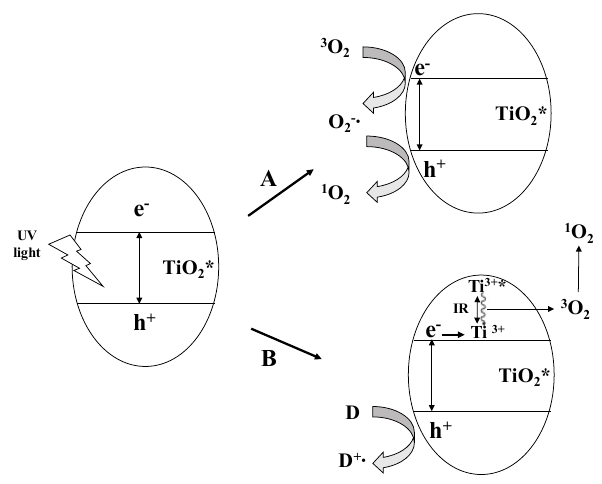
Figure 5. Mechanisms of singlet oxygen formation. A: Nosaka mechanism; B: Macyk mechanism. Notably, the TiO 2 surface has been functionalized in the experiments carried out by Macyk et al. 39